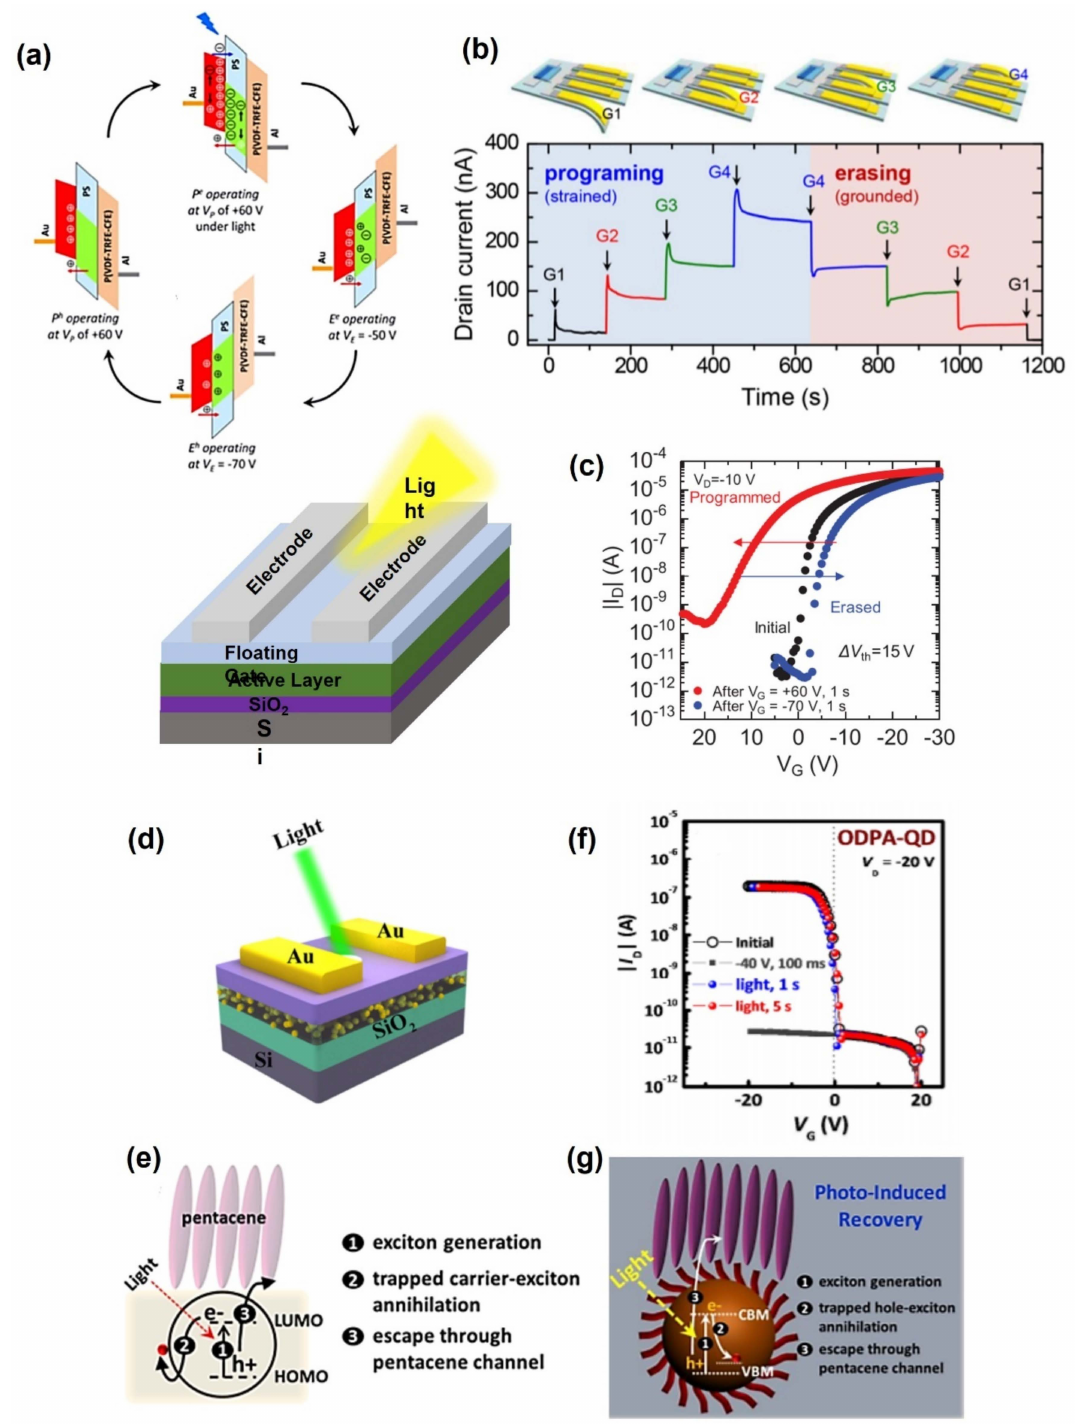
Figure 2. Working mechanisms using polymer floating-gate memory with ( a ) three-level (adapted from [50] with permission from the American Chemical Society) and ( b ) four-level information storage (adapted from [51] with permission from the American Chemical Society); accommodate memory level programming and erasing ( c ) using a photo (adapted from [41] with permission from AIP Publishing) and ( d ) a schematic diagram of photo writes (adapted from [46] with permission from the American Chemical Society); ( e ) principle of photo writers (adapted from [47] with permission from the American Chemical Society); ( f ) a graph of photo erasable memory (adapted from [52] with permission from the American Chemical Society) and ( g ) its principle according to energy bandgap (adapted from [52] with permission from the American Chemical